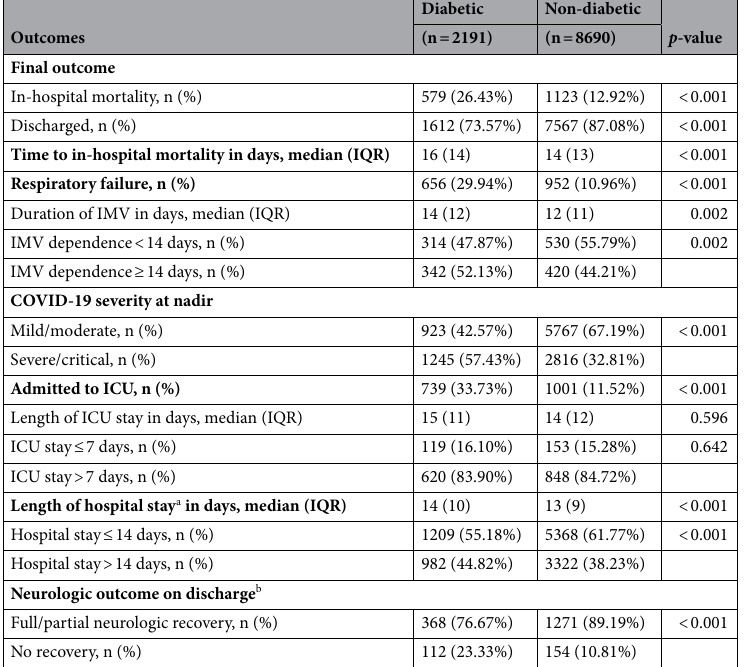
Outcomes* Adj. OR*